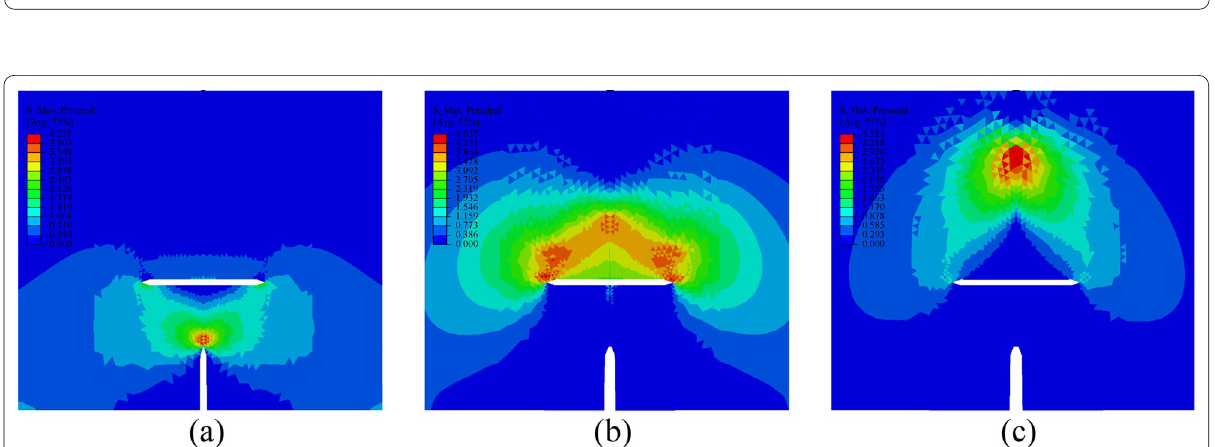
Fig. 11 Evolution of the principal strain field of TPB‑A90‑T2 during the fracture processes: ( a ) crack initiation, ( b ) crack intersection, and ( c ) instability stage